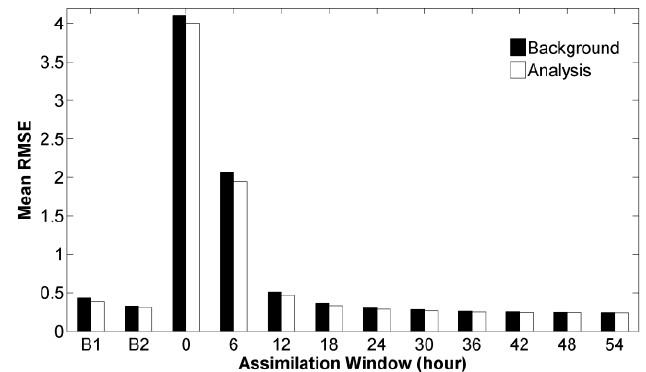
Figure 7. The mean RMSEs of the ETKF (noted as B1), the 4DEnVar (noted as B2), and the DRP-4DVar methods with assimilation window length set as a series of different value from 0 to 54 h. Other assimilation parameters of the DRP-4DVar experiments are the same as those of the DRP-4DVar experiment in Exp-1. The mean RMSEs of the ETKF and the 4DEnVar methods in Exp-1 are used as benchmarks, which are noted as B1 and B2, respectively. The black bars and white bars denote the mean background RMSE and the mean analysis RMSE during the last 500 time steps, respectively.